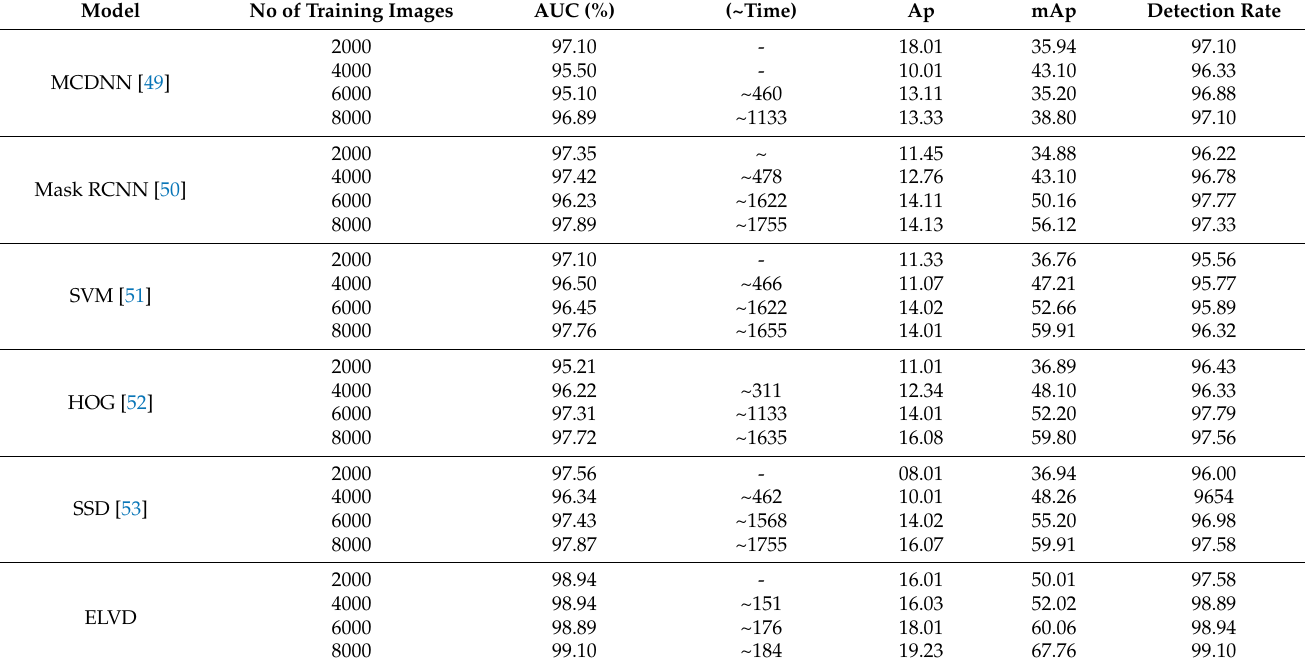
Table 7. Result of ELVD with different State-of-the-Art